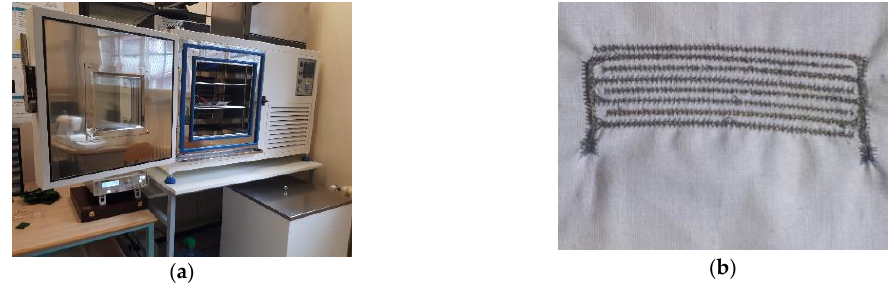
Figure 2. Image of the experimental setup. ( a ) CCK-25/48 Dycometal ( b ) Embroidered capacitive